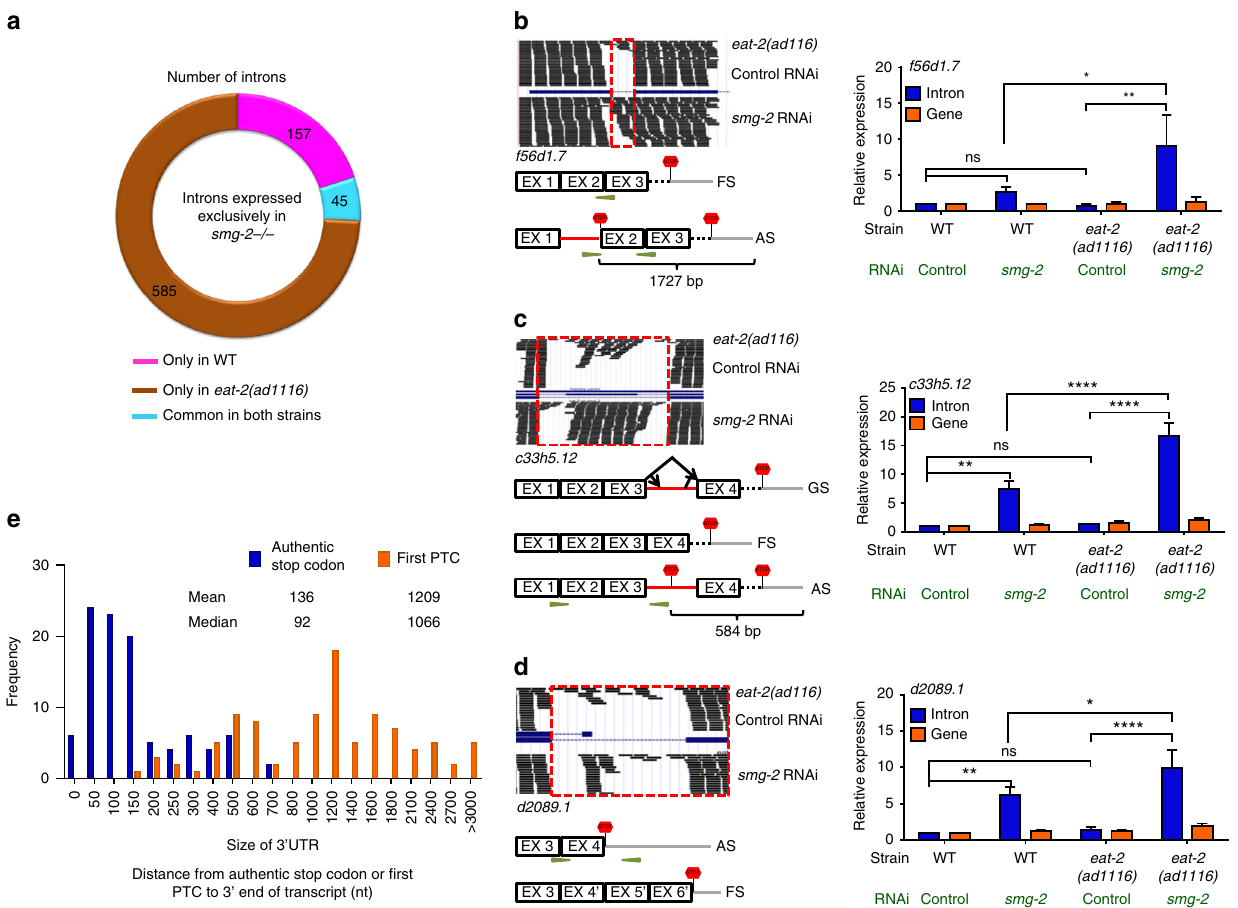
Fig. 5 Genes targeted by AS-NMD during DR. a Number of introns retained when WT or eat-2(ad1116) were grown on smg-2 RNAi. b – d UCSC Browser views show parts of the f56d1.7 , c33h5.12 or d2089.1 genes and mapped sequencing reads when eat-2(ad1116) worms were grown on control or smg-2 RNAi ( upper panel ). A graphical representation (GR) of the two alternate forms ( FS - functionally spliced with normal stop codon; AS -alternatively spliced with a PTC) of the transcripts is shown below the browser view. The qRT-PCR validation of the events, along with the expression of the genes, is presented on the right-hand side . In b – d , differential intron retention ( blue bars ) was detected in eat-2(ad1116) and WT, grown on smg-2 or control RNAi. Expression levels were normalized to actin and compared to WT on control RNAi. Averages of three biological replicates are shown ( error bars = SEM). Asterisks indicate statistically signi fi cant differences as calculated using unpaired two-tailed t- test (* P ≤ 0.05; ** P ≤ 0.01, *** P ≤ 0.001 and **** P ≤ 0.0001; ns non- signi fi cant). The changes in the expression of the respective genes ( orange bars ) were ns. b AS product with PTC is marked in the GR. Primer pairs were designed to quantify the expression of the intron-containing transcript. Distance between PTC and the start of poly-A site is indicated. c The gene structure (GS) of c33h5.12 is presented below the browser view. Rest as ( b ). d The d2089.1 gene has AS of the introns in its 3 ′ UTR to generate transcripts with different UTR lengths. The FS in this case has exons and introns that are utilized as 3 ′ UTR in the AS transcript; this results in an extended 3 ′ UTR. Primer pairs were designed to quantify the expression of the 3 ′ UTR of the AS transcript; they do not amplify the FS transcript. e Frequency distribution of the distance (nt) between the fi rst PTC to the 3 ′ end of the transcript ( orange ) compared to the distance of normal stop codon to the 3 ′ end of the transcript of the same gene ( blue ). The graph shows 100 out of the 630 genes that retained an intron when smg-2 was knocked down in eat-2(ad1116)